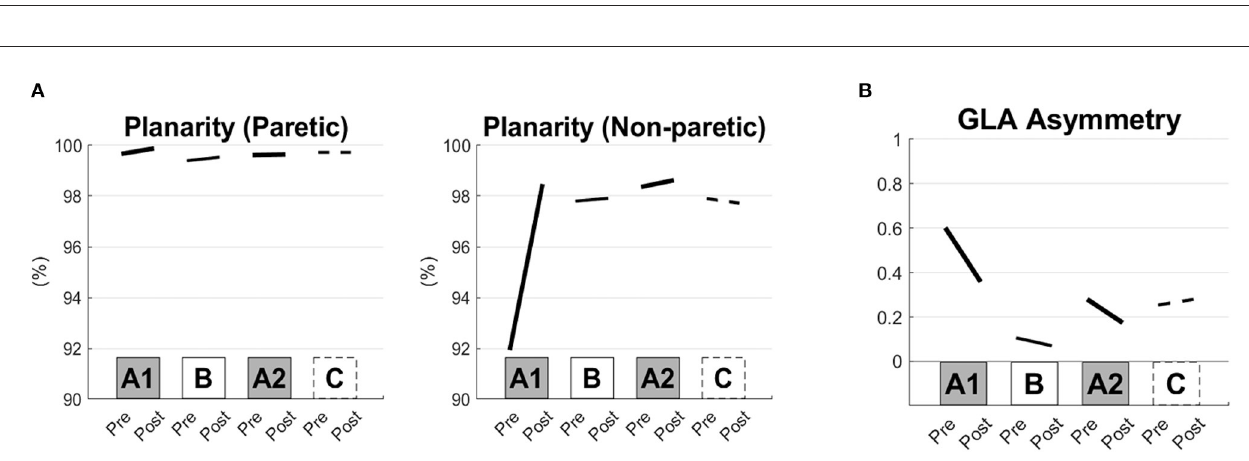
FIGURE2 Kinematic gait parameters before and after the short-term interventions. Planarity of the paretic and non-paretic sides of the lower limbs (A) and areas of the gait loop (GLA) asymmetry (B) are shown before and after each of the interventions (the pre- and post-conditions of the A1, B, A2, and C